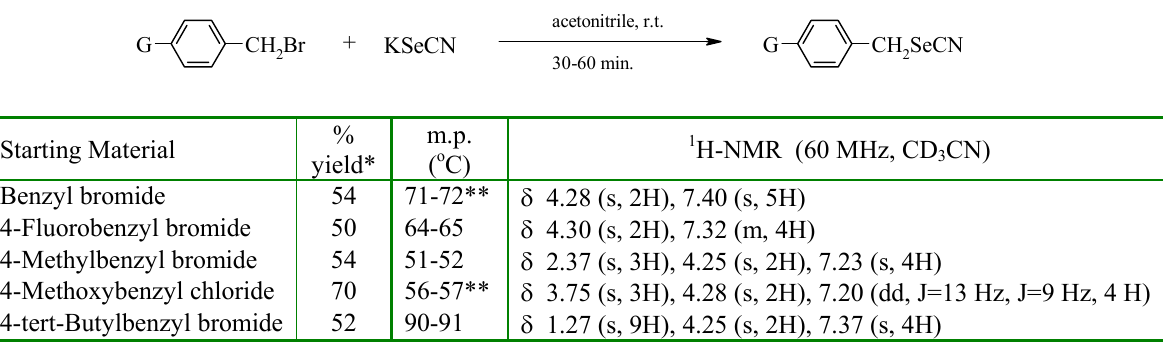
Table 1. The Conversion of Benzylic Halides to